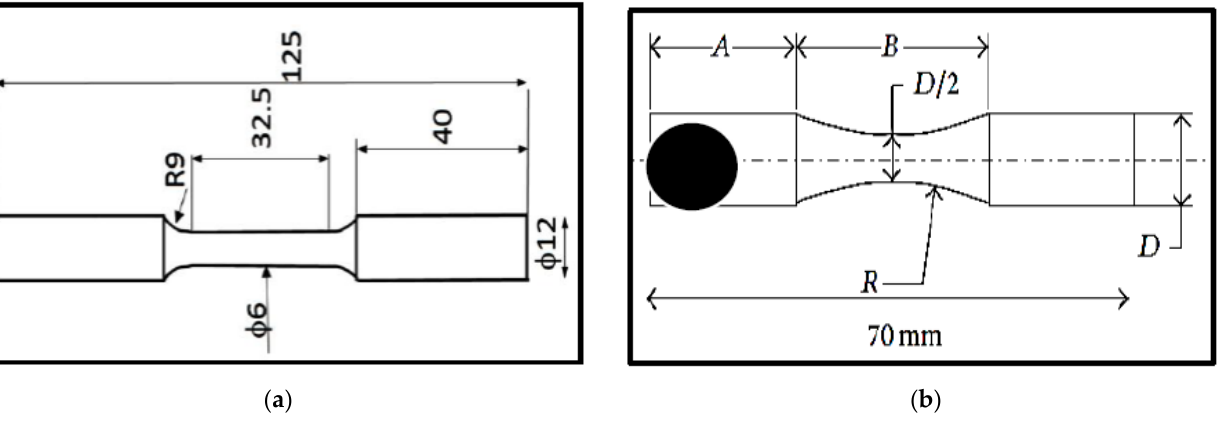
Figure 2. ( a ) Tensile sample — ASTM E-8M, ( b ) Fatigue sample — ASTM E 466 — all dimensions are in mm.